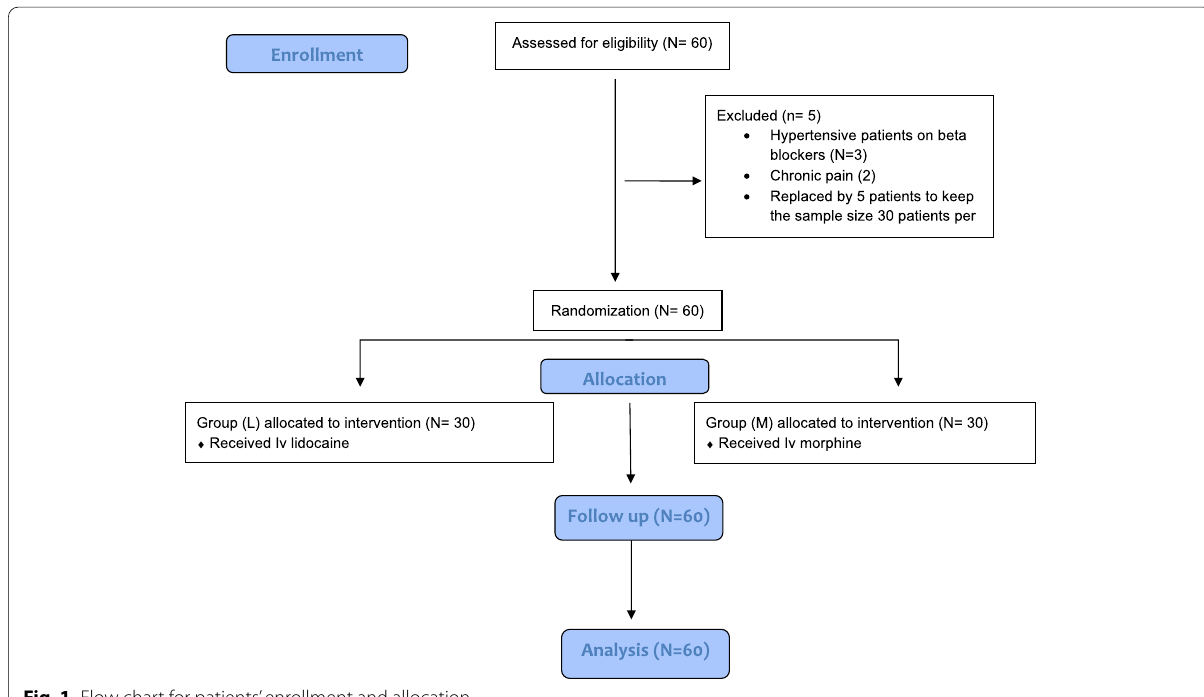
Fig. 1 Flow chart for patients’ enrollment and